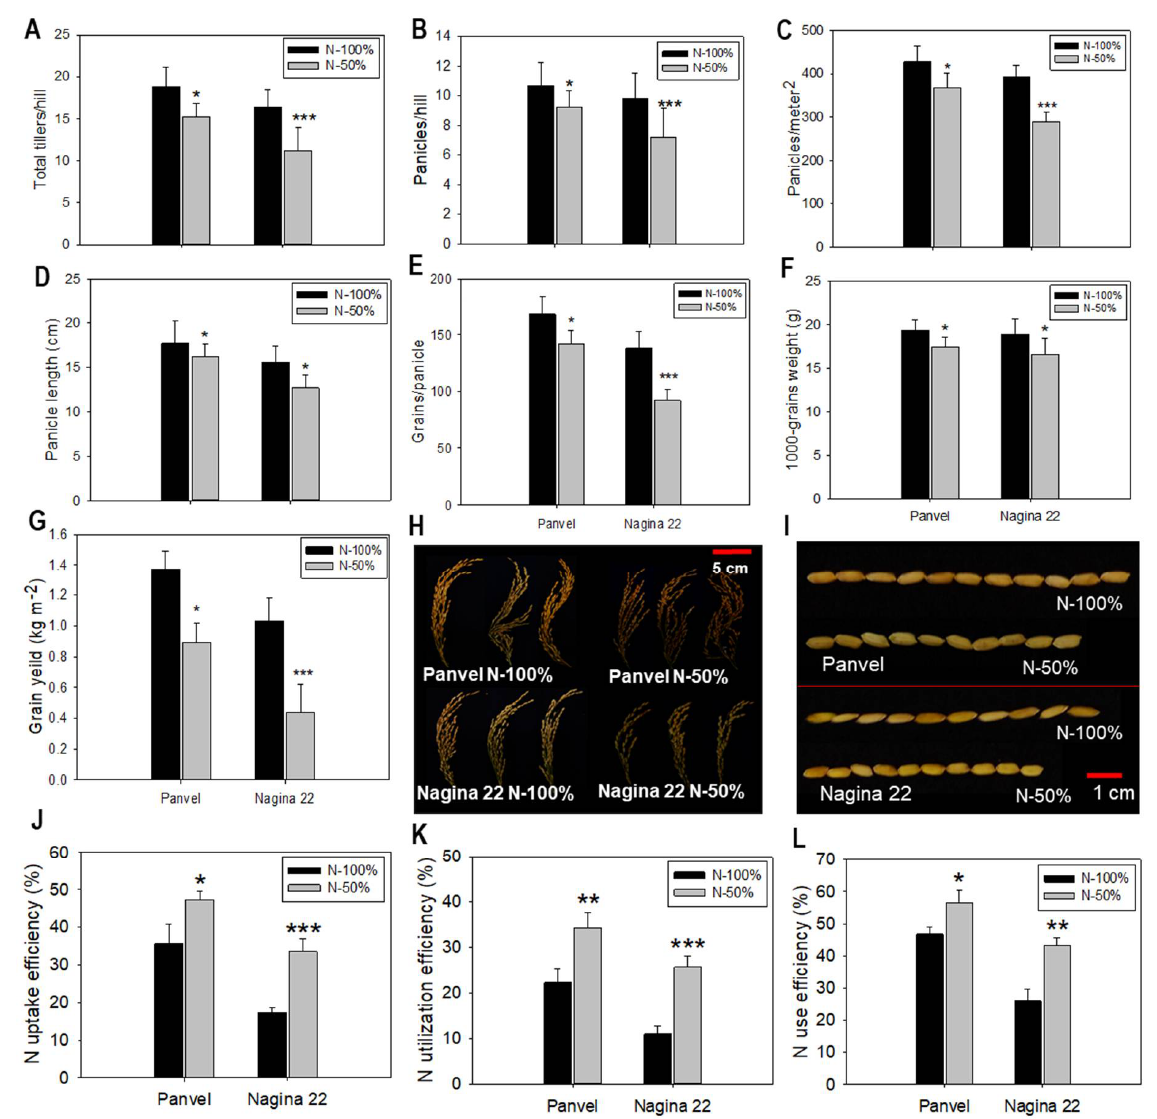
Figure 4. Agronomic and N use efficiency of Panvel and Nagina 22 grown under low N (N–50%) and optimum N (N–100%) supply. Total tillers per hill ( A ), number of panicles per hill ( B ) and number of panicles per meter square ( C ), length of panicles ( D ), number of grains set per panicle ( E ), 1000 grains weight ( F ), grain yield per meter square ( G ), size of panicles ( H ) and ten rice grains ( I ), and percentage of N uptake efficiency ( J ), N utilization efficiency ( K ), and N use efficiency ( L ). Bars in each graph represent the mean ± SE of each treatment, and the asterisks denote the significant differences at * p < 0.05, ** p < 0.01, and *** p < 0.001 between treatments of each cultivar. Nitrogen uptake efficiency (NUpE), N utilization efficiency (NUtE), and N use effi- ciency (NUE) were calculated after harvesting the crop and were improved in low N treated plants as compared to optimum N-treated plants in both rice cultivars. The NUpE increased by 13.82% more in Panvel than in Nagina 22 under low-N supply (Figure 4J), whereas the NUtE increased by 8.7% more in Panvel than in Nagina 22 (Figure 4K). The overall NUE improved in Panvel by 13.22% more than in Nagina 22 under low N-supplied plants; with regard to NUE, both cultivars grown under low-N conditions exhibited significant differences in comparison to the optimum N-supplied plants (Figure